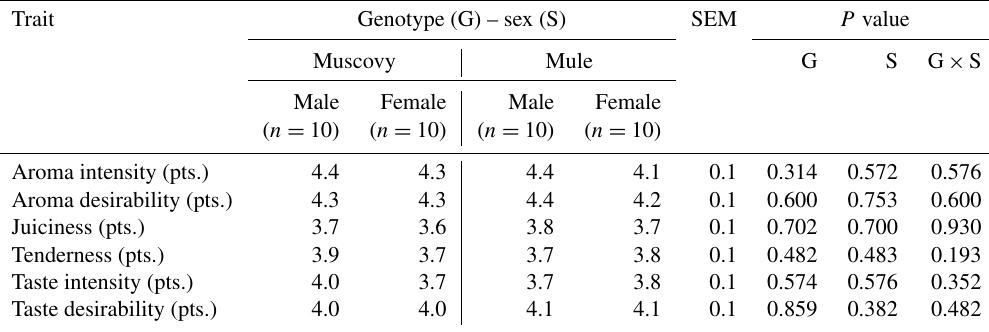
Table 6. Sensory properties of pectoralis major muscle in ducks of different genotypes. Trait Genotype (G) – sex (S) SEM P value Muscovy Mule G S G × S Male Female Male Female ( n = 10) ( n = 10) ( n = 10) ( n = 10) Aroma intensity (pts.) Aroma desirability